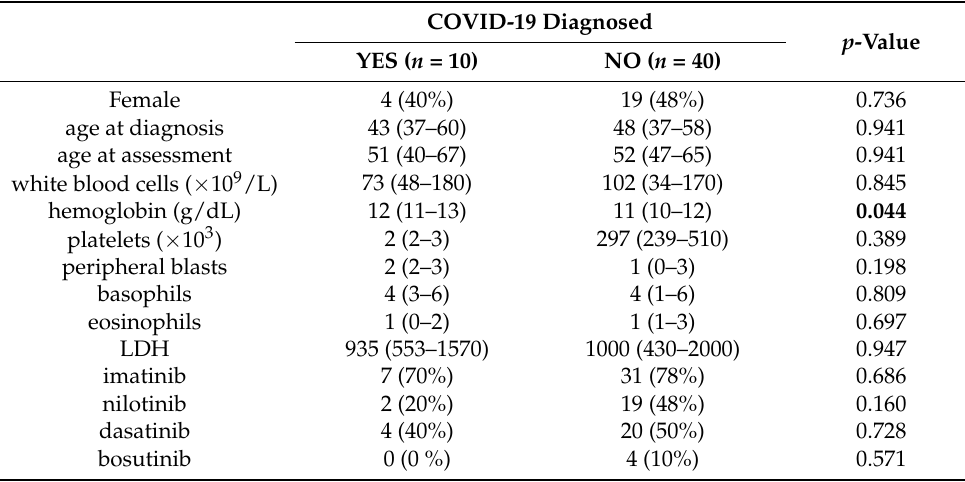
Table 5. Statistical analysis of possible risk variables for COVID-19 infection in CML